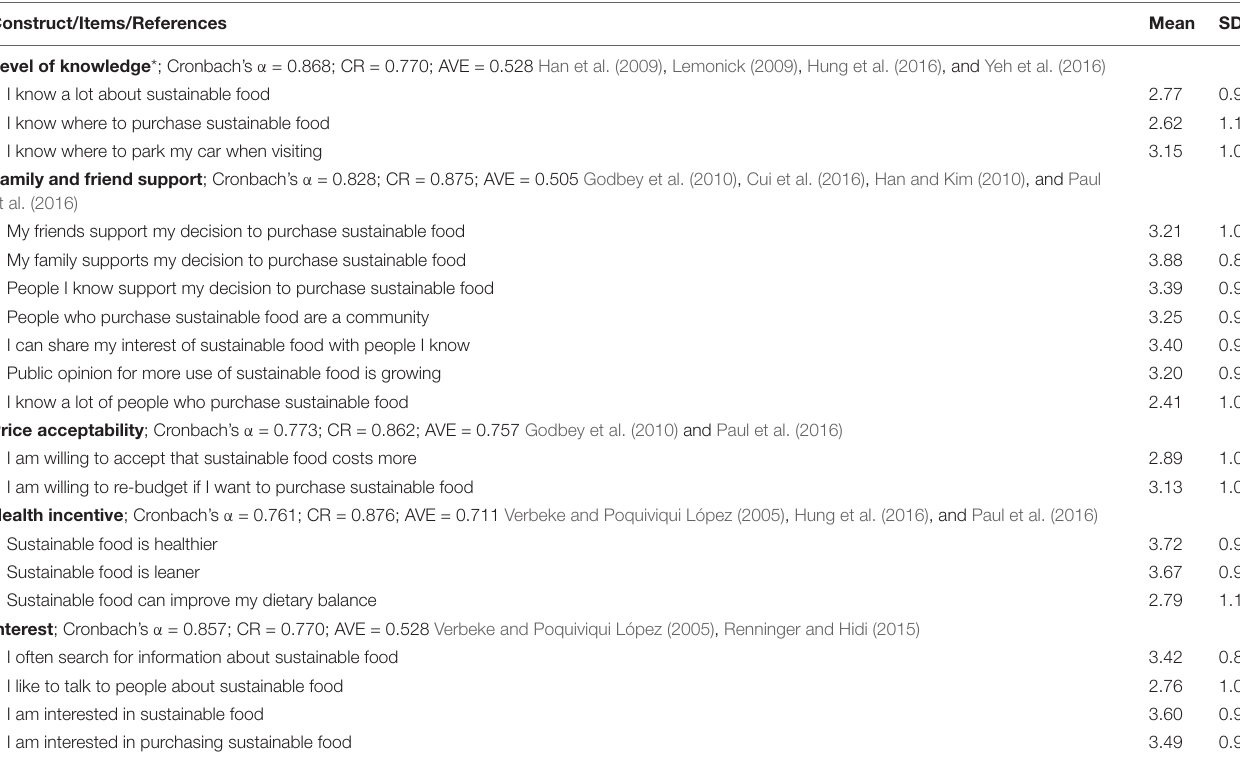
TABLE 1 | Items used in the survey.